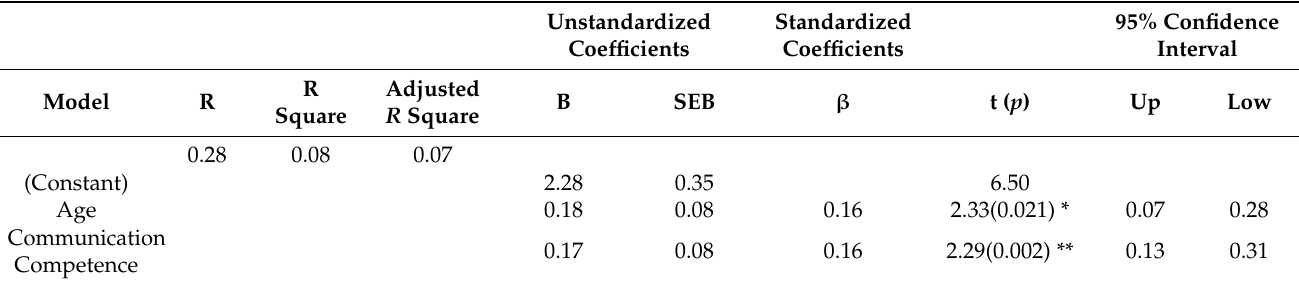
Table 3. Factors affecting community empowerment ( n =